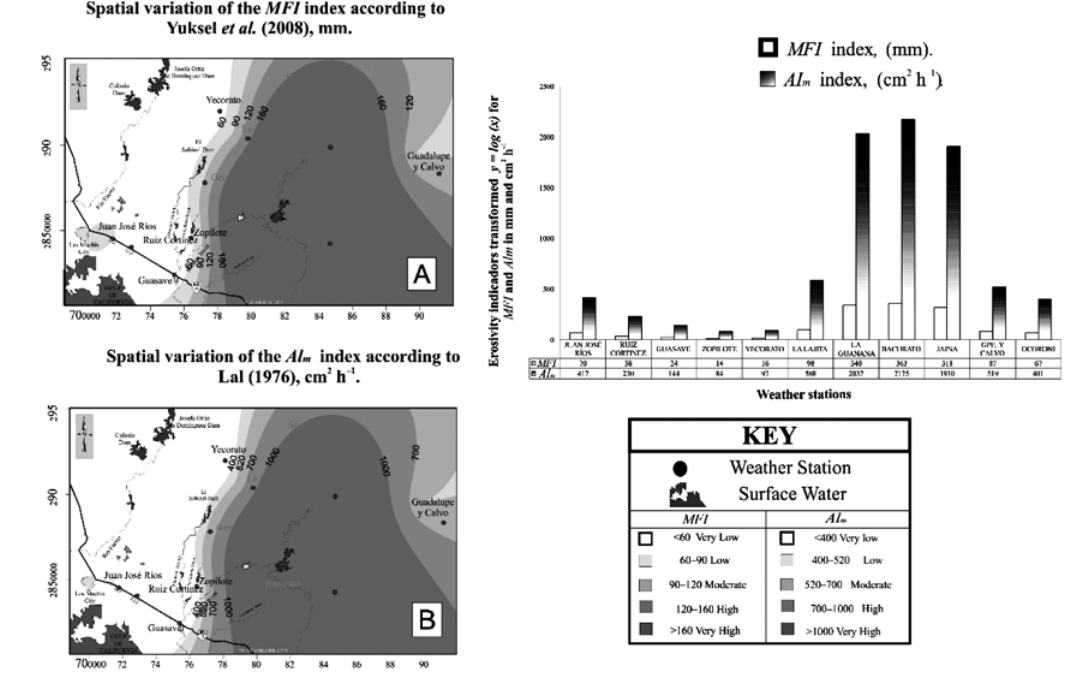
Fig. 4. Spatial variation of the MFI index (mm) and AI